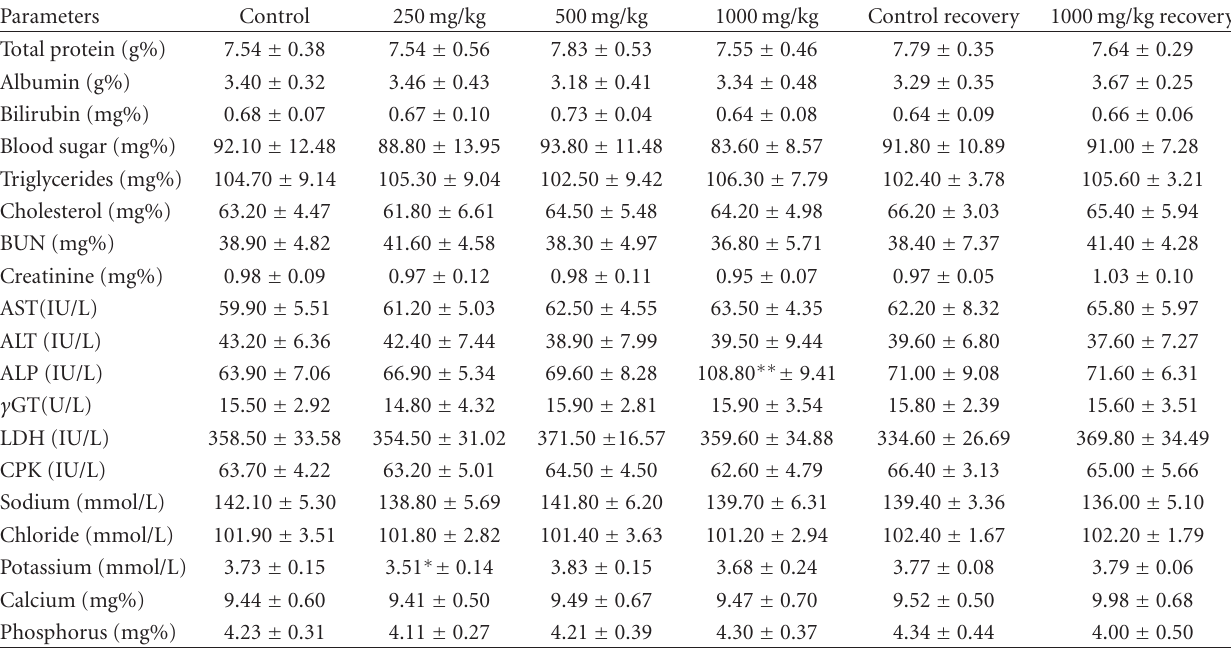
Table 5: Clinical chemistry data (mean ± SD) of female rats after oral administration of Zigbir (cid:2) for 90 days. Parameters